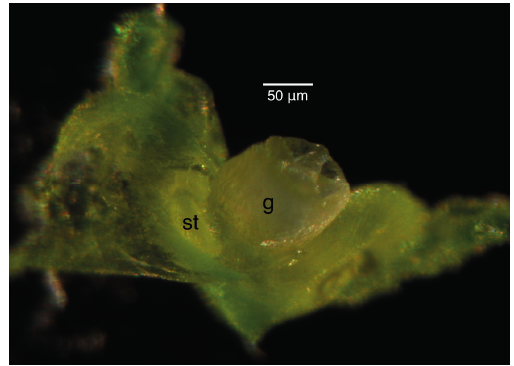
Figure 7. Stage 7 female uninfected floral bud. The gynoecium has a “barrel and star” appearance from the top. Stamen primordia can be observed. Size bar, approximately 50 µm. g, gynoecium; st,